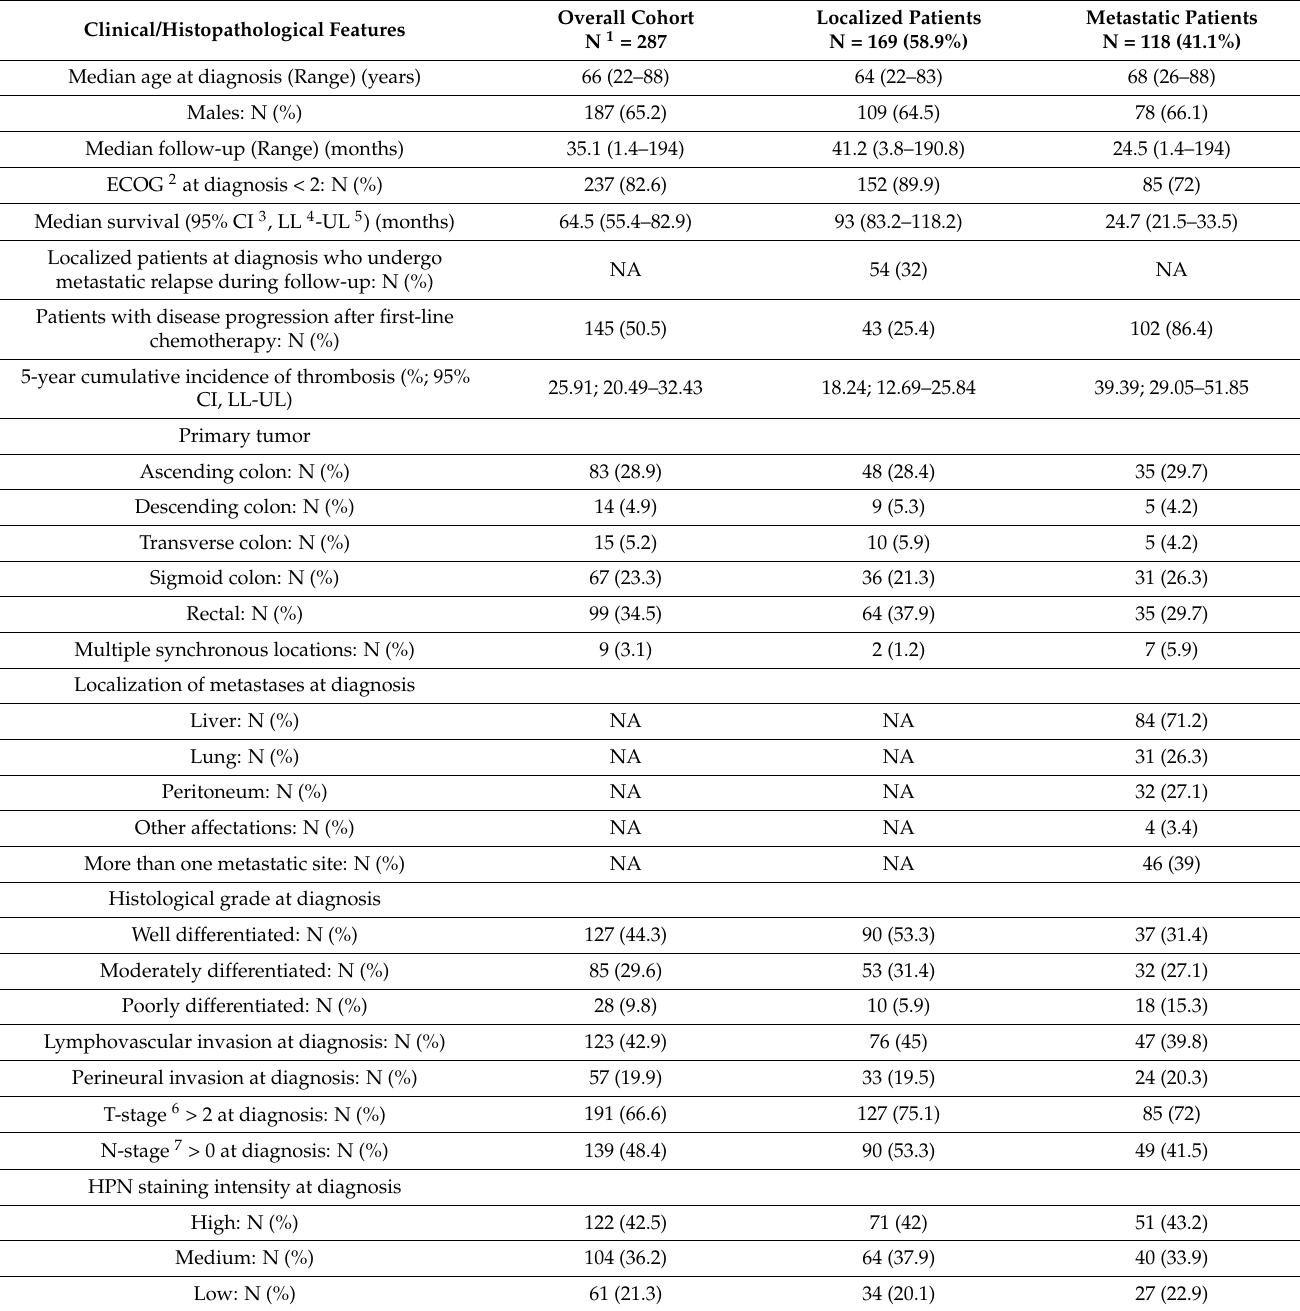
Table 1. Clinical and histopathological characteristics of patients from the